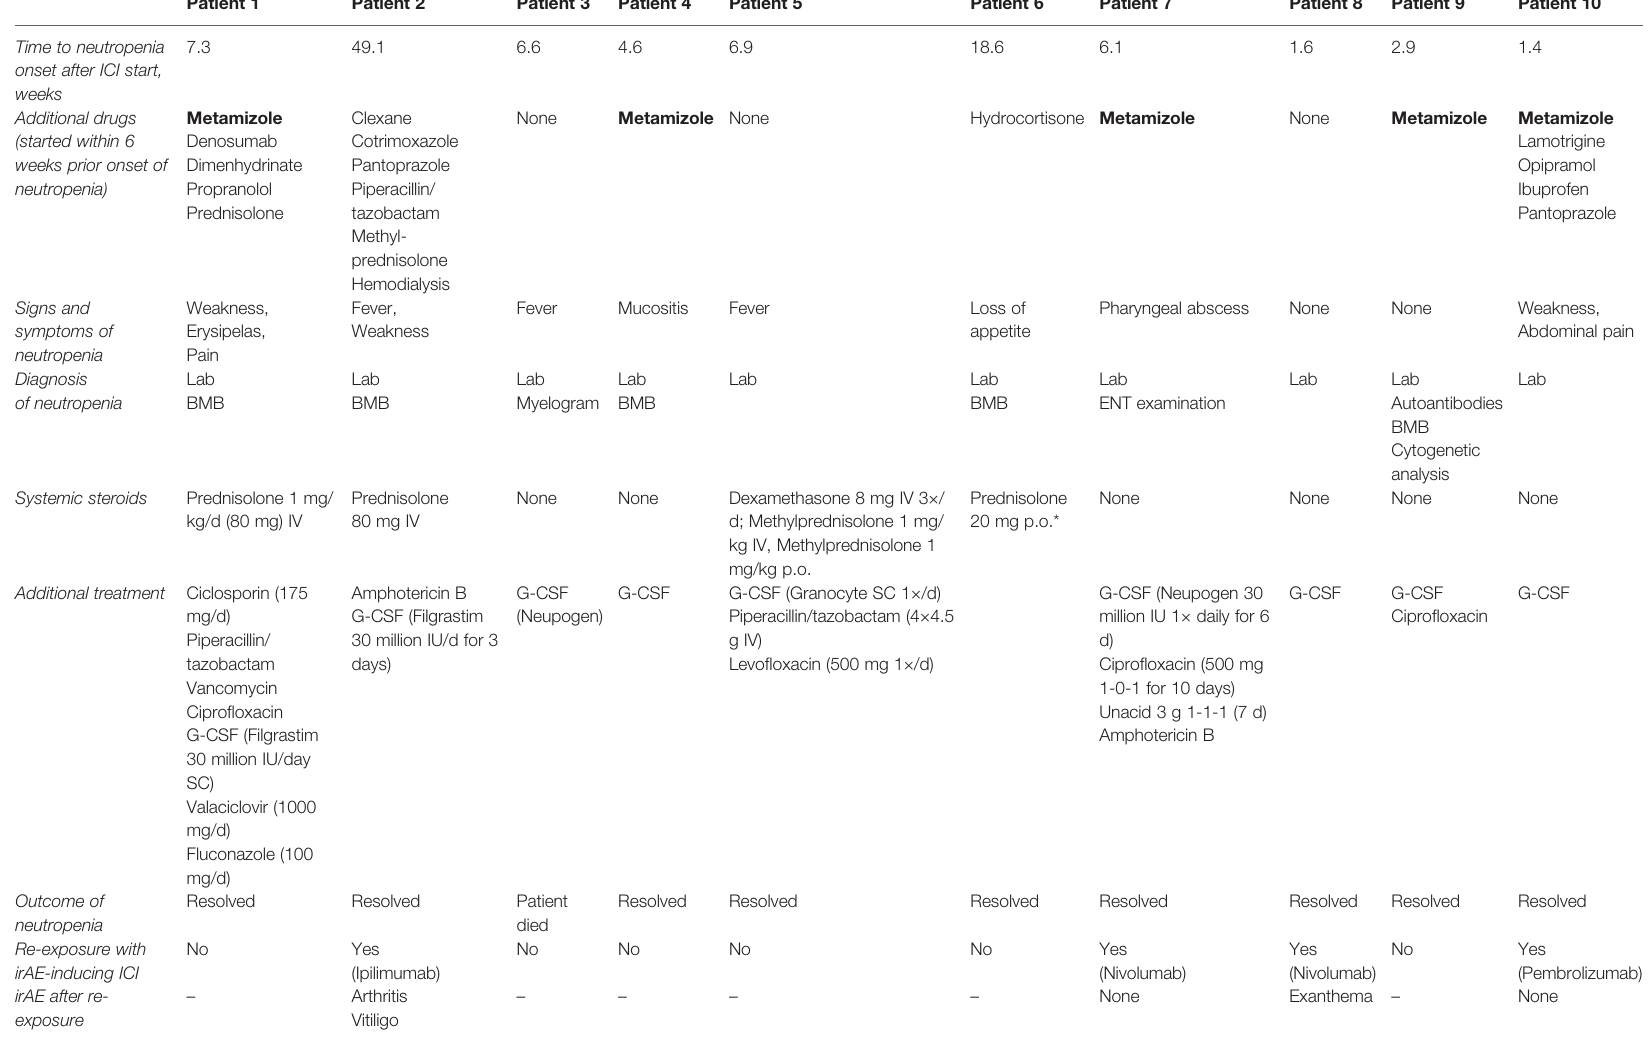
BMB, bone marrow biopsy; ENT, ear-nose-throat; G-CSF, granulocyte colony-stimulating factors; ICI, immune checkpoint inhibition; ipi, ipilimumab; ir-, immune-related; irAE, immune-related adverse event; IV, intravenously; lab, laboratory diagnostics; nivo, nivolumab; SC, subcutaneously; pembro, pembrolizumab. *started before grade 4